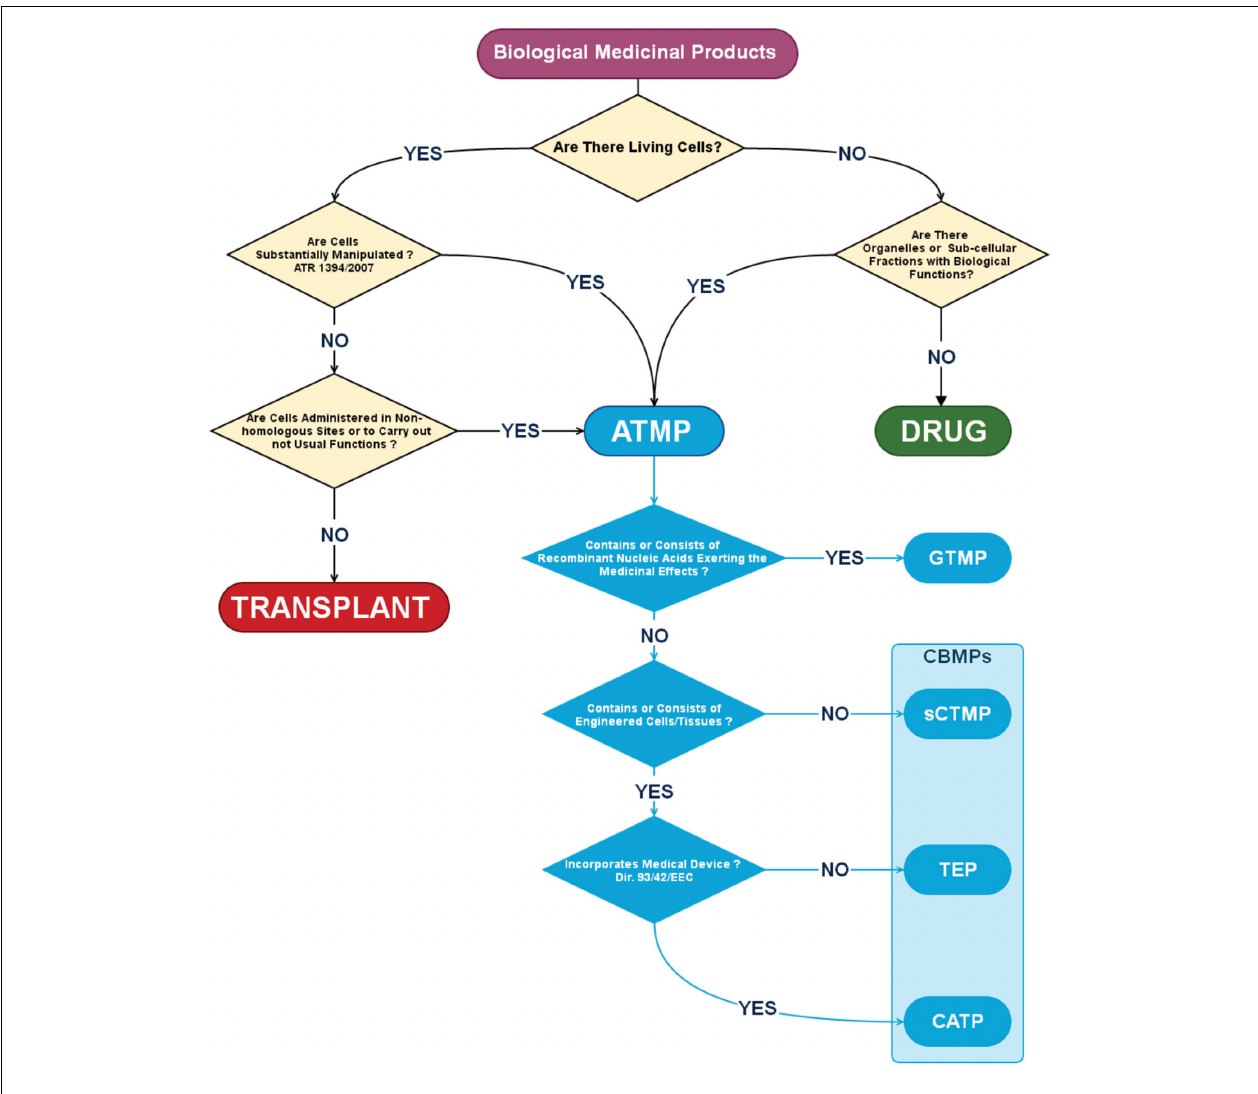
FIGURE 1 | Algorithm for the definition of a Cell-Based Medicinal Product (CBMP). According to the European Medicines Agency (EMA) a Biological Medicinal Product should be considered an Advanced Therapy Medicinal Product (ATMP) if contains, or consist of living cells undergoing substantial manipulation and/or administered in non-homologous sites. ATMP includes also medicinal products in which the therapeutic effect is carried out by organelles or sub-cellular fraction like in Gene Therapy